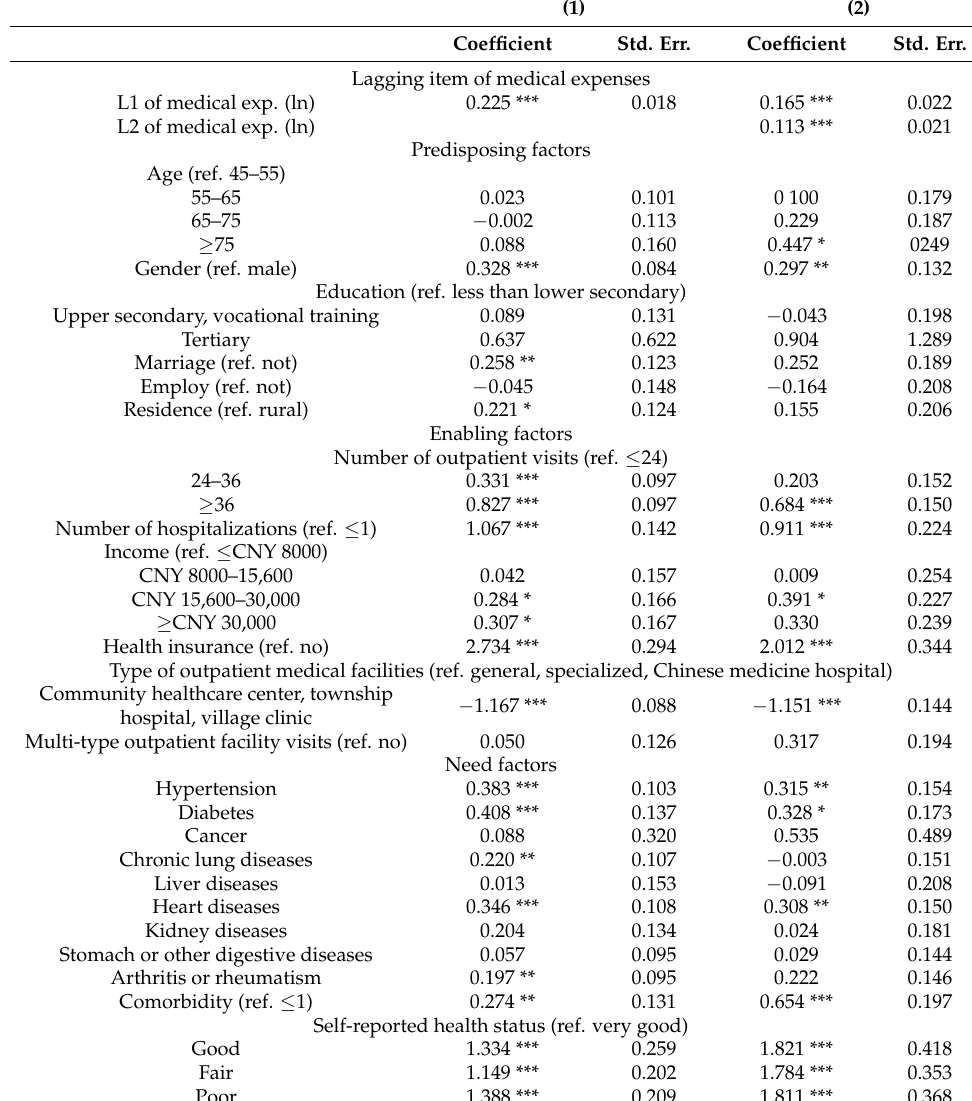
Table 6. Heckman regression coefficients: Regression on total medical